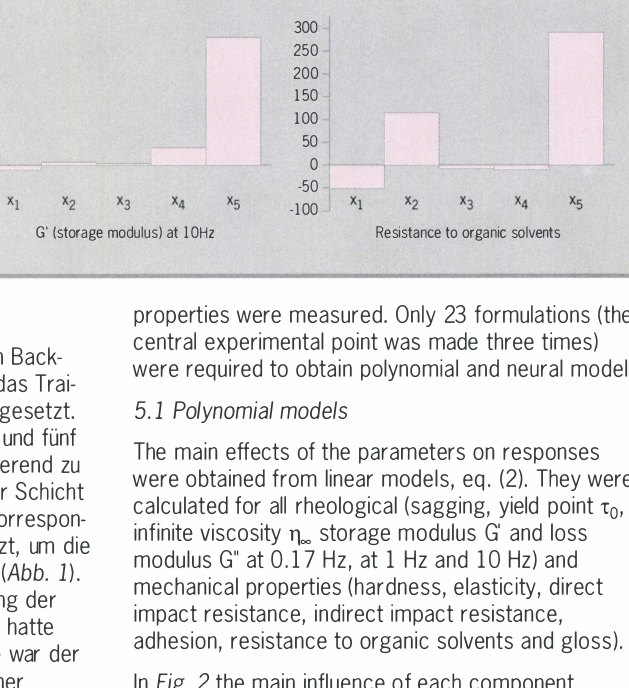
Table 1: Data used for modelling